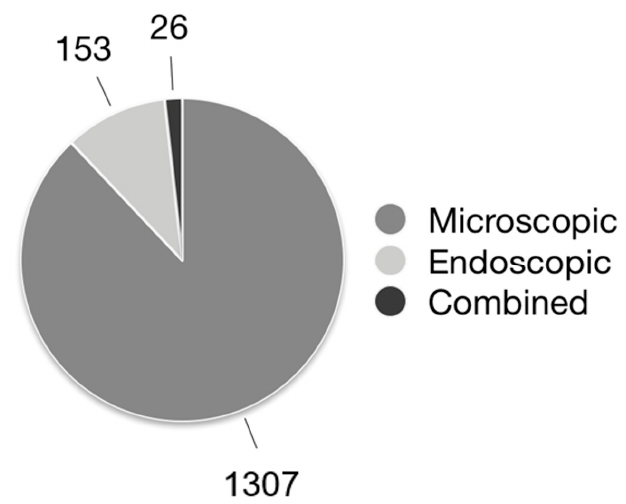
Figure 3. Surgical techniques applied in the included cohorts of patients. Table 2. Summary of included articles.